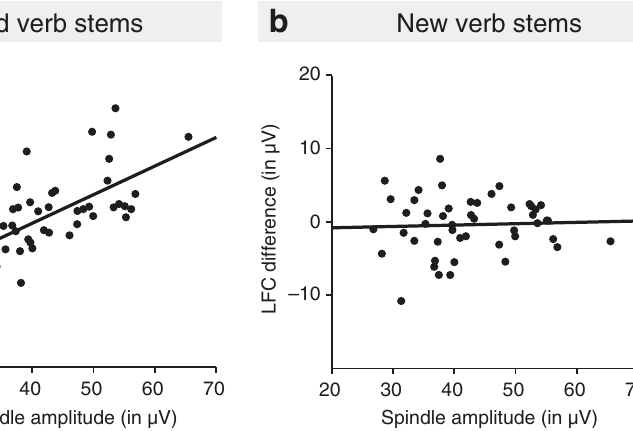
Fig. 4 | Relationbetweensleepspindlesand leftfrontal-centralERPdifference. a Relationbetweenmeanpeak-to-peakamplitudeofsleepspindlesmeasuredinleft frontal, mid-frontal, and left central regions during the post-encoding nap and the leftFCMR(theERPdifferencebetweenirregularandregularsentencesovertheLFC region) for NAD phrases with old verb stems in the memory test phase (Pearson ’ s r =0.600, P =7×10 − 6 , 95% CI=[0.380, 0.755], two-sided). LFC region as in Fig. 3c. b Lack of relation between mean peak-to-peak amplitude of sleep spindles mea- sured in left frontal, mid-frontal, and left central regions and the (non-signi fi cant)